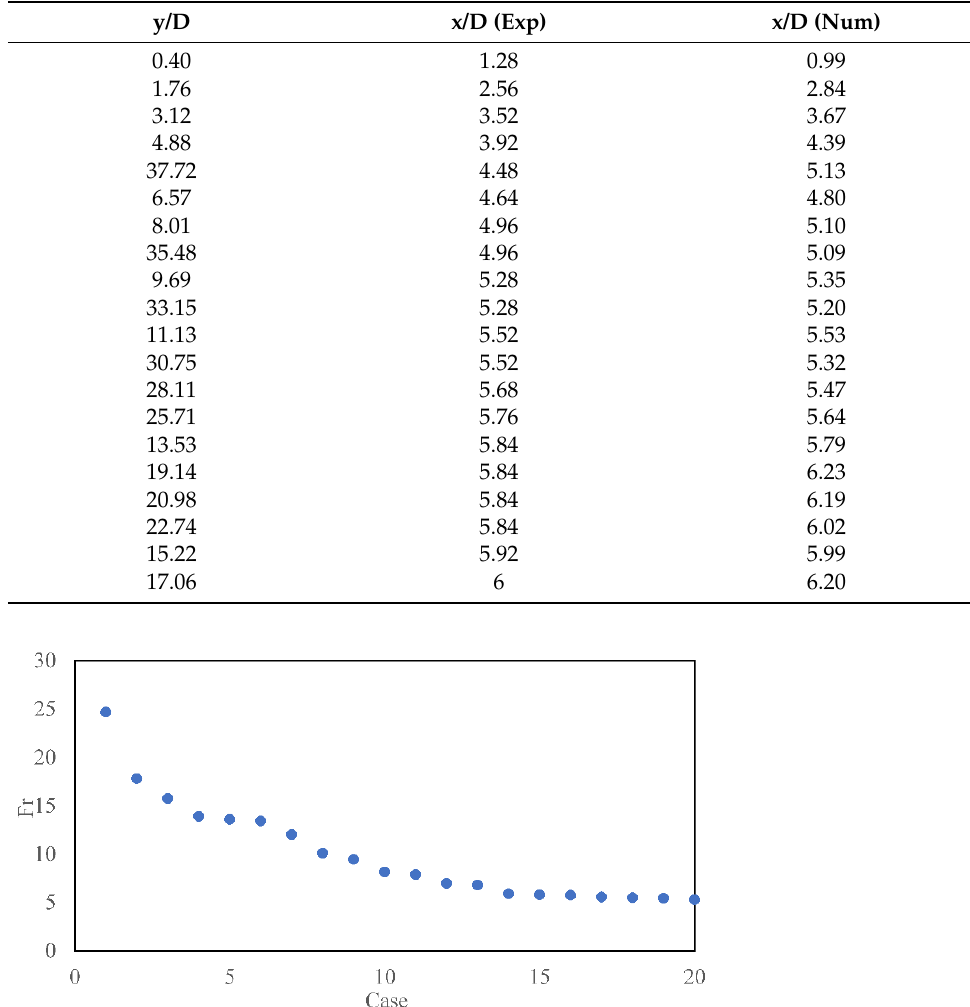
Table 2. Comparison of experimental results and simulation results.